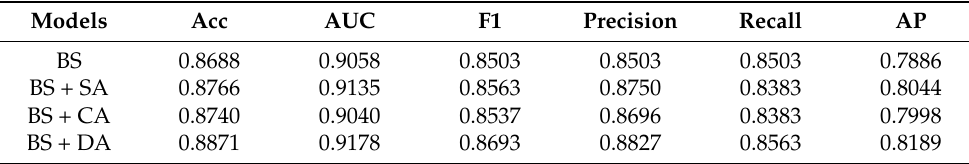
Table 6. The performance results of ablation study on attention mechanism.